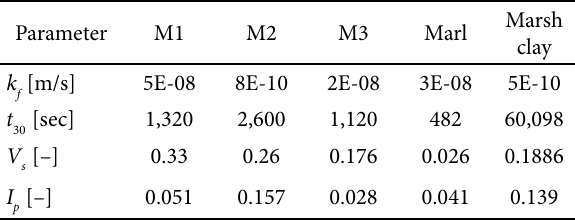
Table 15. Calculation parameters to determine the evaluation